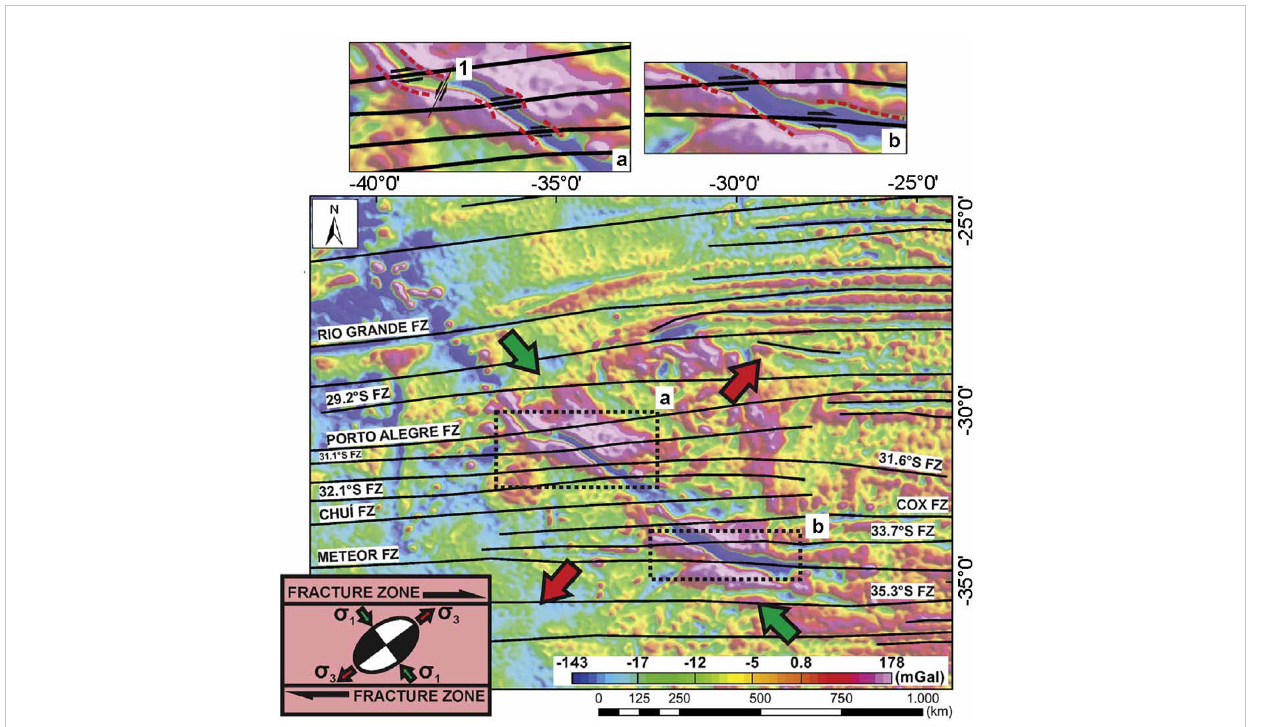
FIGURE 11 Free-Air anomaly map presenting the tectonic events which originated the Cruzeiro do Sul Rift. FZ = Fracture Zone. (A, B) shows the main in fl ection points of the Rift in its north and south segments, respectively. 1 is the magnetic lineament that crosses the study area and its in fl ection (Modi fi ed by Galvão and De Castro, 2017).